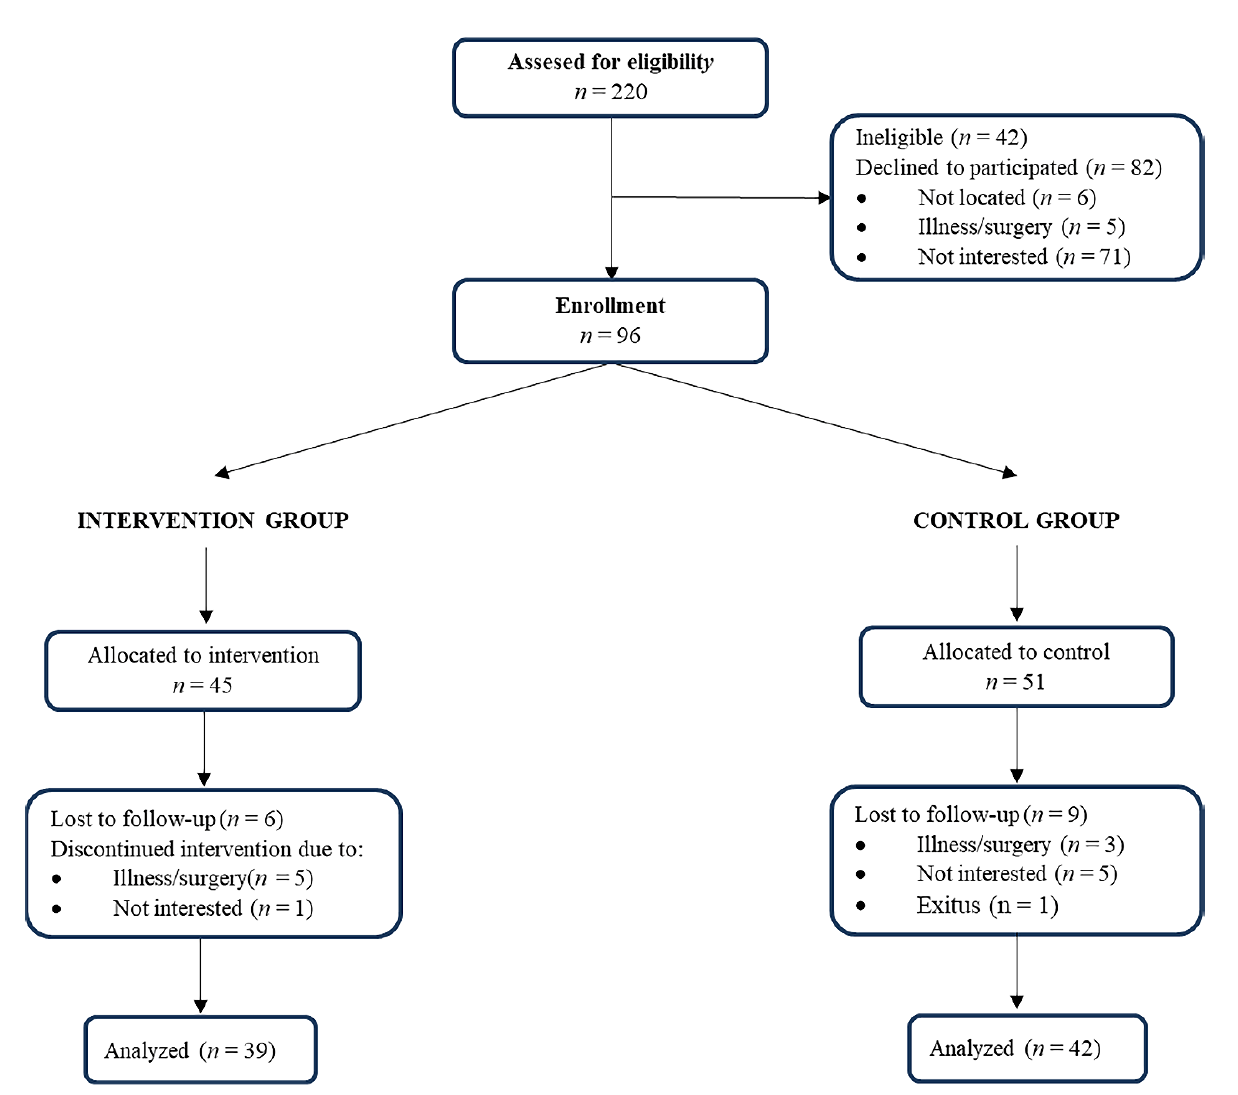
Figure 1. CONSORT diagram showing the flow of the participants through the trial.